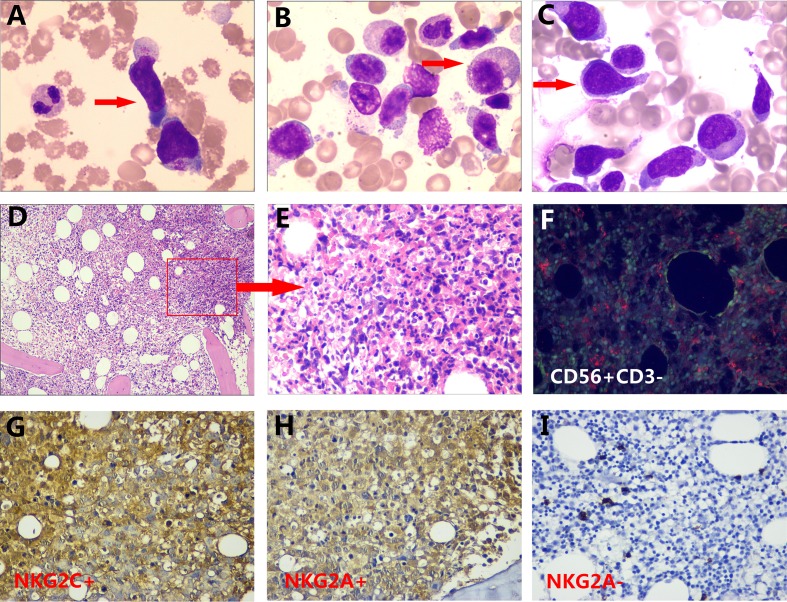
Morphological characteristics of ANKL.(A-C) Large granular lymphocytes, large cells with oval or irregular nuclei and abundant cytoplasm, and coarse azurophilic granules that are clearly visible (red arrow; Wright-Giemsa-stained samples from patients 5, 11 and 36 showed at ×1000). (D, E) Bone marrow biopsy from an ANKL patient showing extensive infiltration of abnormal NK cells (red arrow, from patient 22) (picture E is an enlargement of picture D) (paraffin-embedded, hematoxylin-eosin stained sample from patient 32 showed at ×200,). (F) Double immunofluorescent staining of CD56 (green) and CD3 (red) showingCD56+/CD3- NK cells in one patient’s bone marrow (paraffin-embedded sample from patient 30showed at×400).(G-I) Immunohistochemical results from aberrant NK cells in bone marrow, with NKG2C (brown) positivity(90.5%) (G), NKG2A (brown) positivity (from an EBV+ patient with ANKL) (H) and NKG2Anegativity (from an EBV- patient with ANKL) (I)(paraffin-embedded samples from patient 27, 28 and 29 showed at ×400).